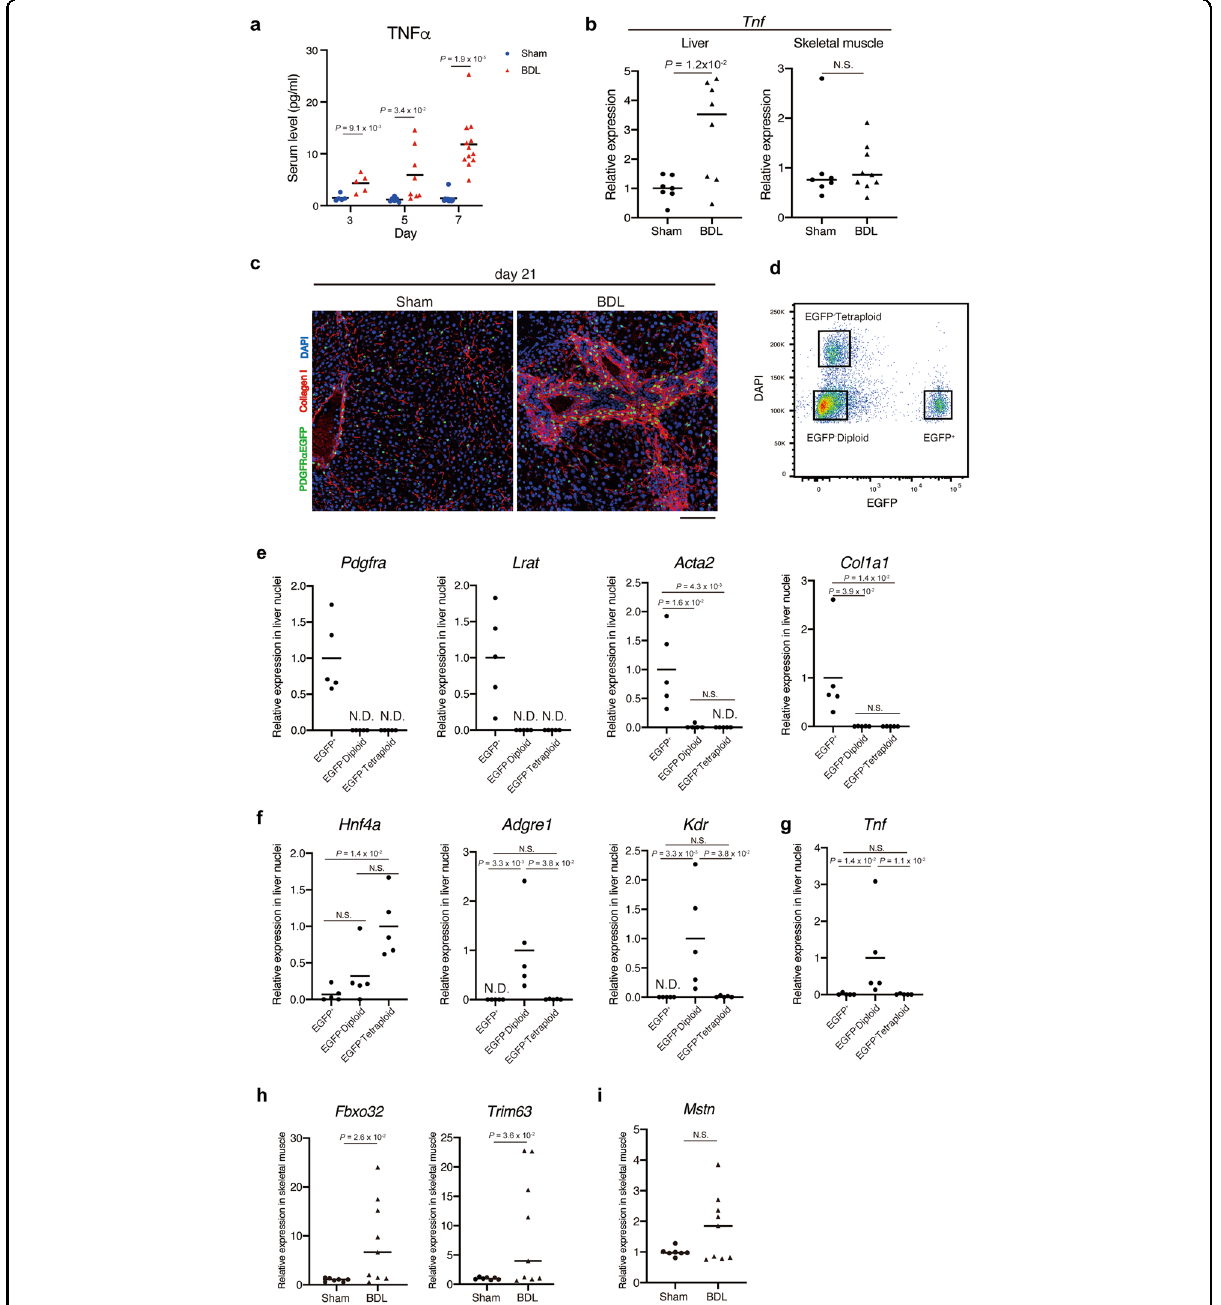
Fig. 5 Tnf expression is up-regulated in the liver but not in the skeletal muscle of BDL mice. a Serum levels of TNF α at day 3, 5, and 7 post- operation were measured using ELISA. b The expression level of Tnf was quanti fi ed in the liver (left) and skeletal muscle (right) at day 7 post-operation. c Liver sections of Pdgfr α EGFP mice at day 21 post-operation were subjected to immuno fl uorescence staining for collagen I and DAPI. d A representative FACS plot for nuclei isolation. Nuclei were isolated from freshly frozen fi brotic livers of Pdgfr α EGFP mice using FACS. Three gates were set as indicated in the plot to isolate EGFP + , EGFP − diploid, and EGFP − tetraploid nuclei. e The expression levels of hepatic stellate cell markers ( Pdgfra and Lrat ) and fi brosis markers ( Acta2 and Col1a1 ) were quanti fi ed. f The expression levels of the hepatocyte marker ( Hnf4a ), Kupffer cell marker ( Adgre1 ), and endothelial cell marker ( Kdr ) were quanti fi ed. g Quantitative analysis of Tnf gene expression. h The expression levels of Fbxo32 and Trim63 in the skeletal muscle were quanti fi ed. i The expression levels of Mstn in the skeletal muscle were quanti fi ed. n = 5, 6, and 9 (sham) and 5, 8, and 12 (BDL) mice for day 3, 5, and 7, respectively ( a ), n = 7 (sham) and 8 (BDL) mice for the liver, n = 7 (sham) and 9 (BDL) mice for the skeletal muscle ( b , h , i ), and n = 5 mice ( e – g ). Data represent individual data points and the means. Data were analysed using the two-sided unpaired t -test, t -test with Welch ’ s correction, or Kruskal – Wallis non-parametric test followed by Dunn ’ s post hoc test. NS not signi fi cant, ND not detected. Scale bar, 100 μ m ( c ).